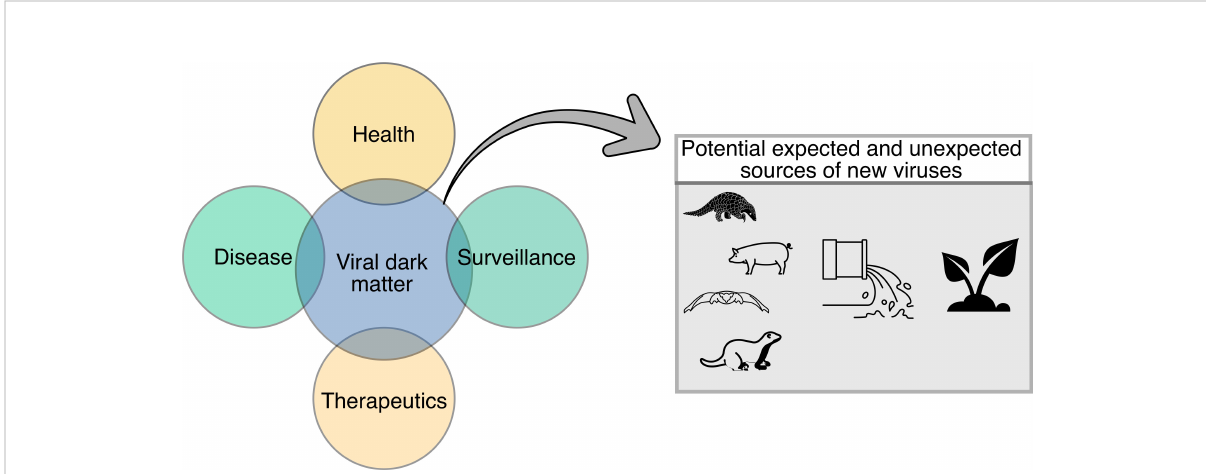
FIGURE 3 Diagram demonstrating potential applications of the viral dark matter in health, disease, therapeutics, and surveillance. Potential expected and unexpected sources of new viruses (i.e., animal, and environmental) that could contribute to the viral dark matter are also